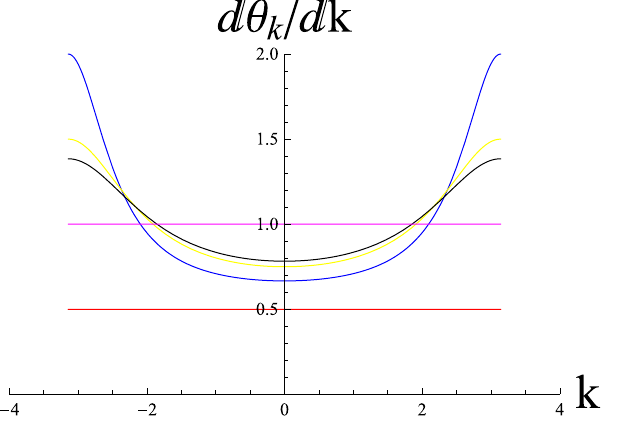
Figure 3. The variation of θ d k with k . The curve for the magenta color ( W = 1) is for μ = 0 and the other curves dk are for μ = 1. Here we consider Δ = J . Different curves are for the different values of ( Δ = J ). Red (0.5), blue (1), yellow (1.5) and black